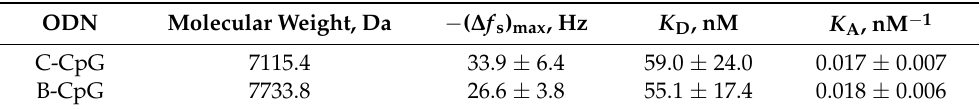
Table 3. The ( ∆ f s ) max , equilibrium constants of dissociation, K D , and association, K A , ( K A = 1/ K D ) of the LRR11-ODN complex, determined using the Langmuir fit (Equation (1)) of the experimental data presented in Figure 5 for the TSM biosensor with immobilized 5 (cid:48) -biotinylated oligonucleotides C-CpG and